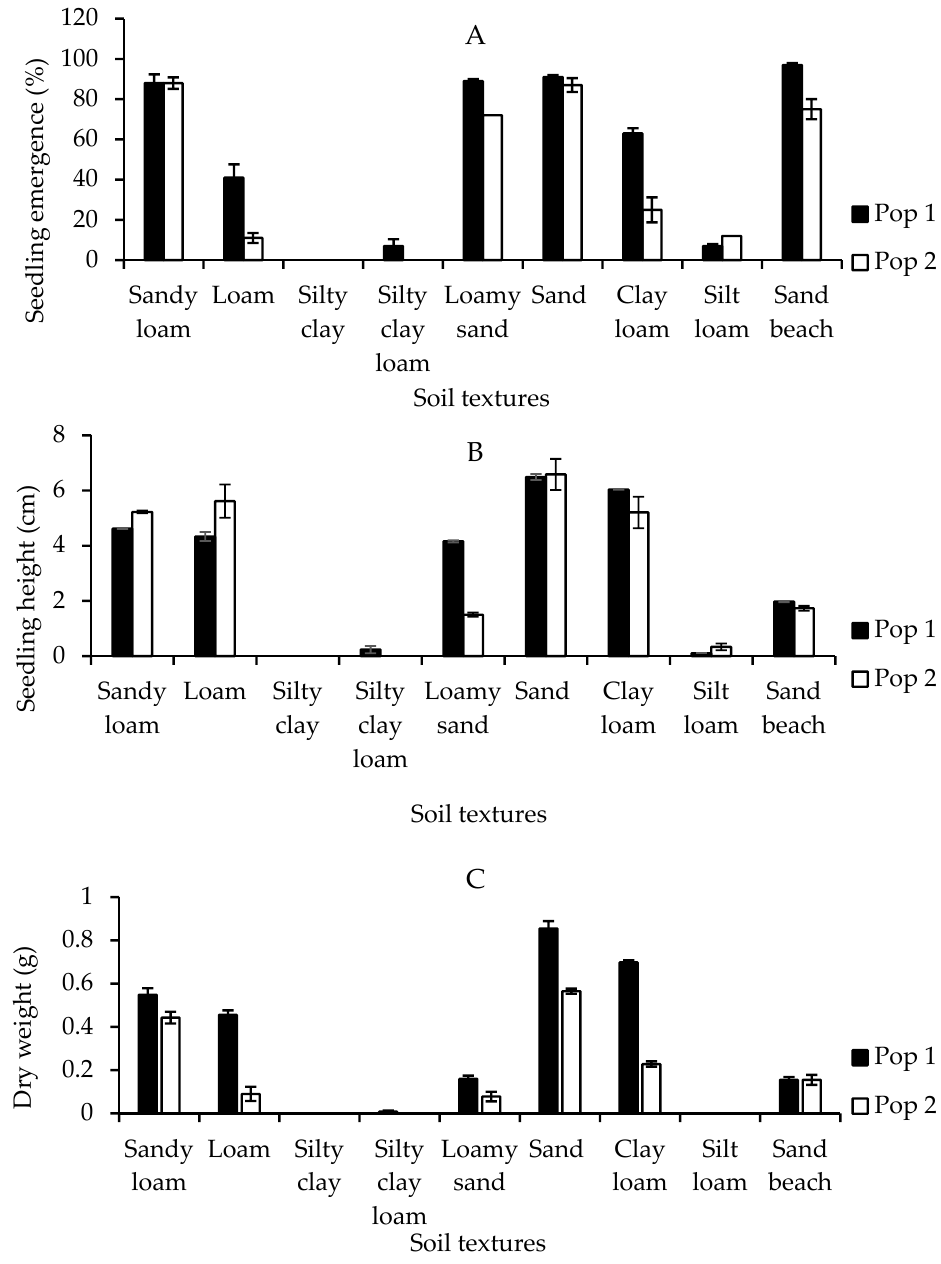
Figure 5. Percentage of seedling emergence ( A ), seedling height ( B ), and seedling dry weight ( C ) of different Parthenium weed populations grown on different soil textures.